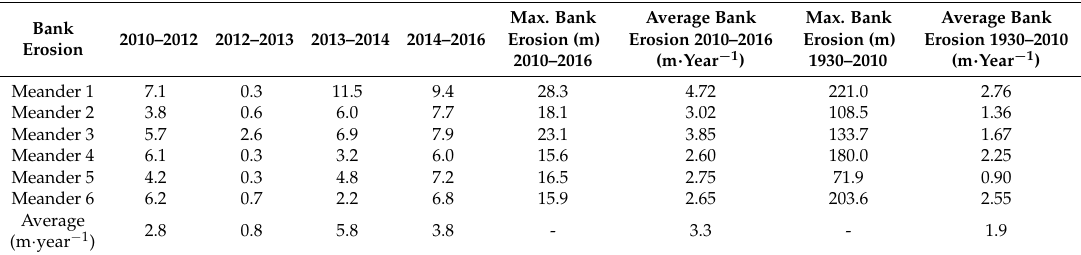
Table 4. Bank erosion rate in the period